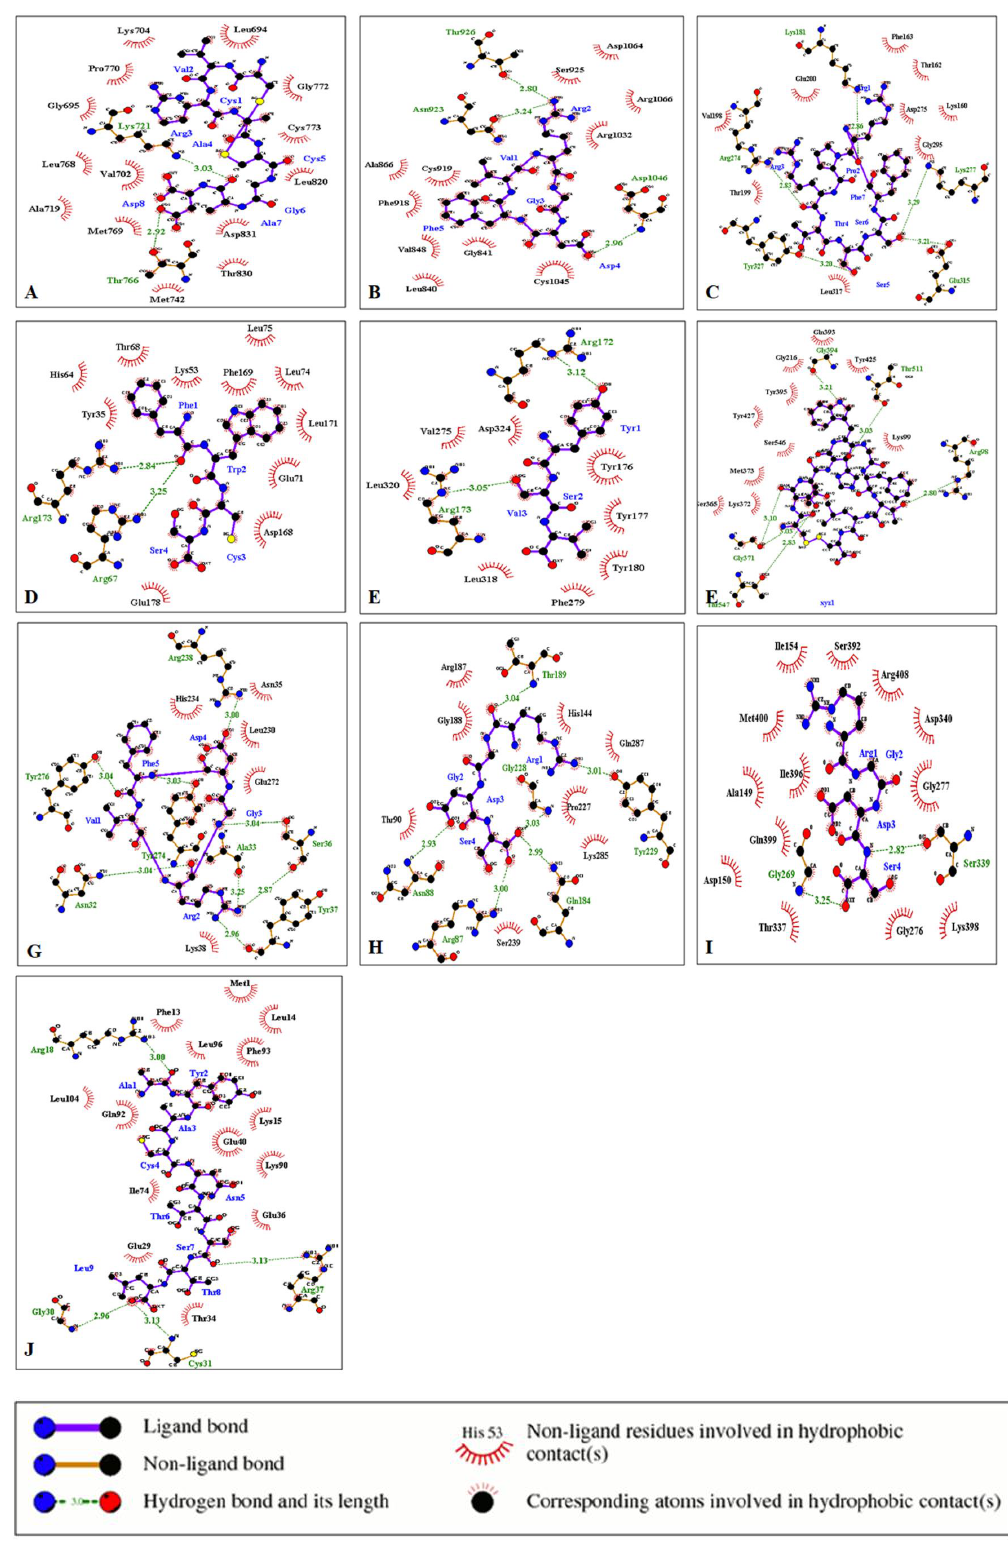
Figure 6. Protein–ligand interactions using LigPlot. ( A ) CVRACGAD and EGFR kinase. ( B ) Cilengitide and VEGFR2 kinase. ( C ) RPRTSSF and PKB. ( D ) FWCS and p38. ( E ) YSV and PTEN. ( F ) CTTHWGFTLC and MMP-2. ( G ) Cilengitide and Procaspase 3. ( H ) RGDS and Procaspase 7. ( I ) RGDS and Caspase 9. ( J ) AYACNTSTL and